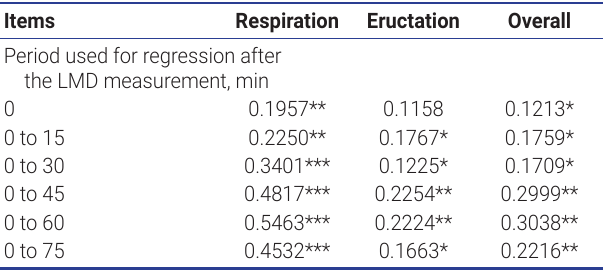
Table 2. Correlation coefficients between the infrared-absorption-based gas analyzer and laser methane detector datasets in Exp 1 Items Respiration Eructation Overall Period used for regression after the LMD measurement, min